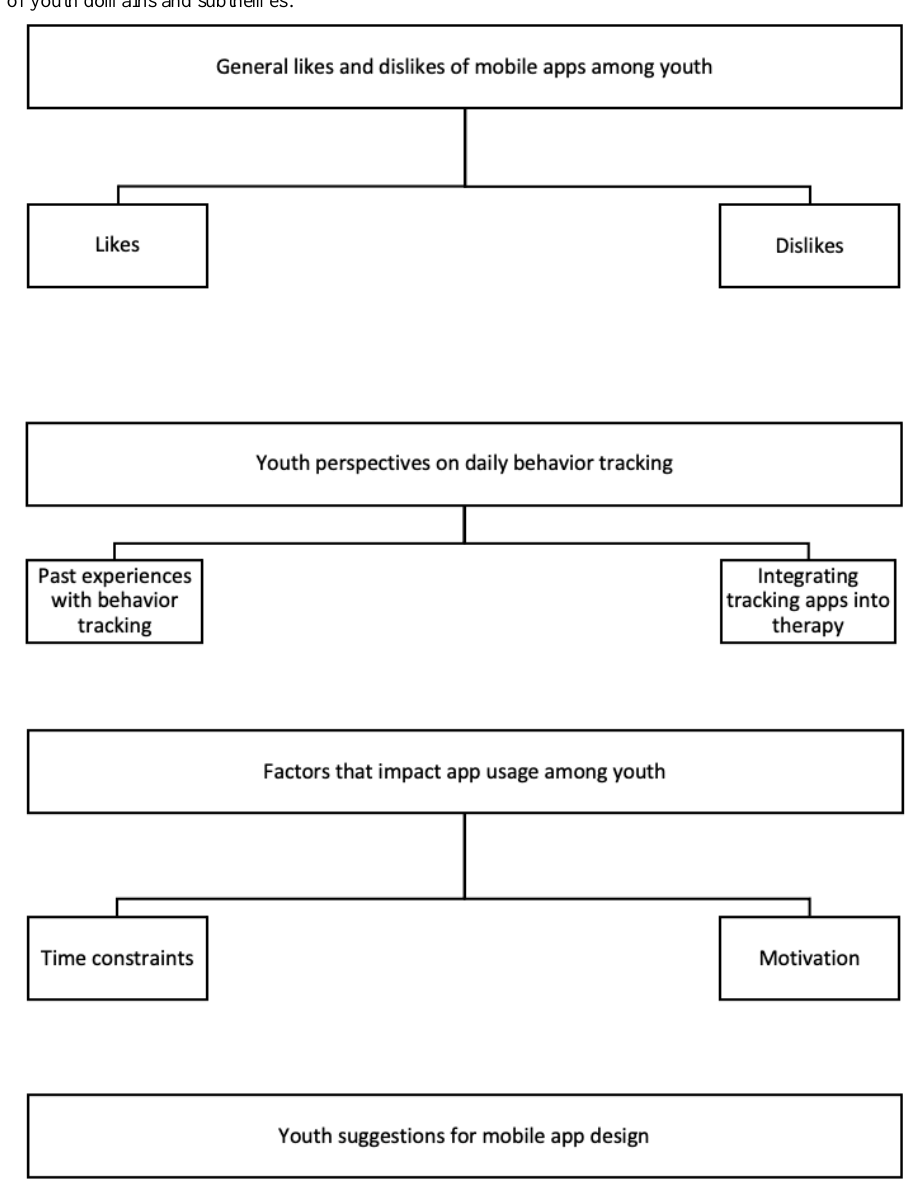
Figure 1. Summary of youth domains and